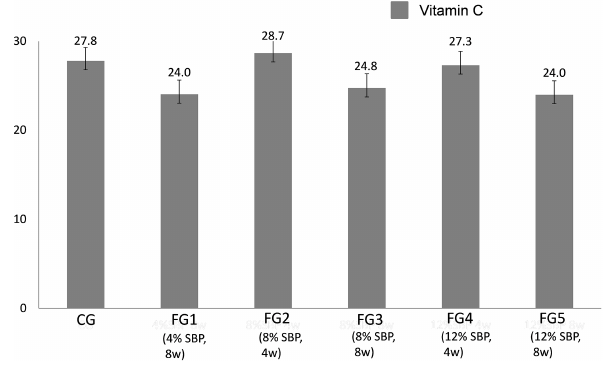
Figure 2. Vitamin C concentrations (µgg − 1 ) of longissimus muscle of pigs whose diets were supplemented with sea buckthorn pomace (LSM ±